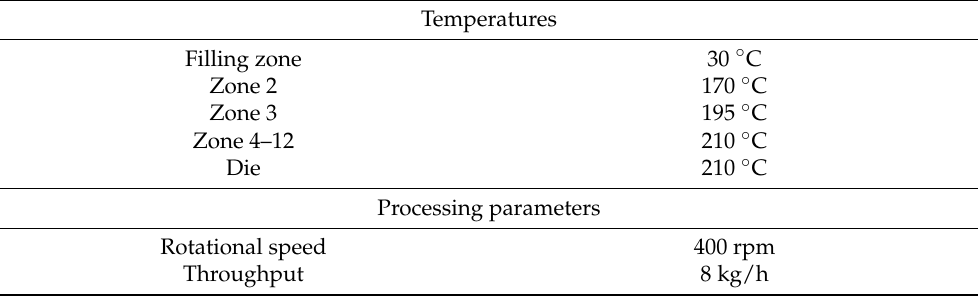
Table 5. Processing parameters of the compounding